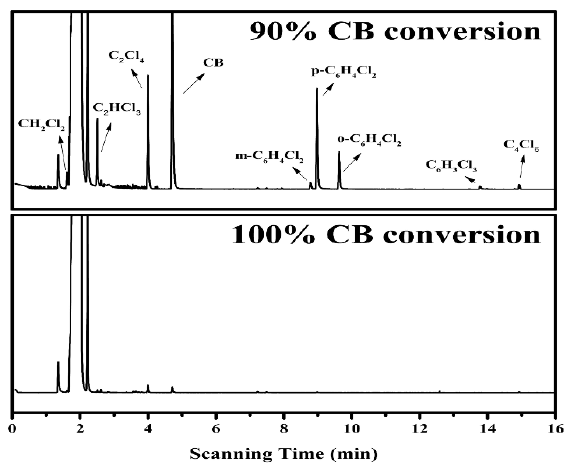
Figure 13. The gas chromatography-mass spectrometer (GC-MS) chromatograms of organic by-products in off-gas at different CB conversion rates over the MCZ-0.67 catalyst.